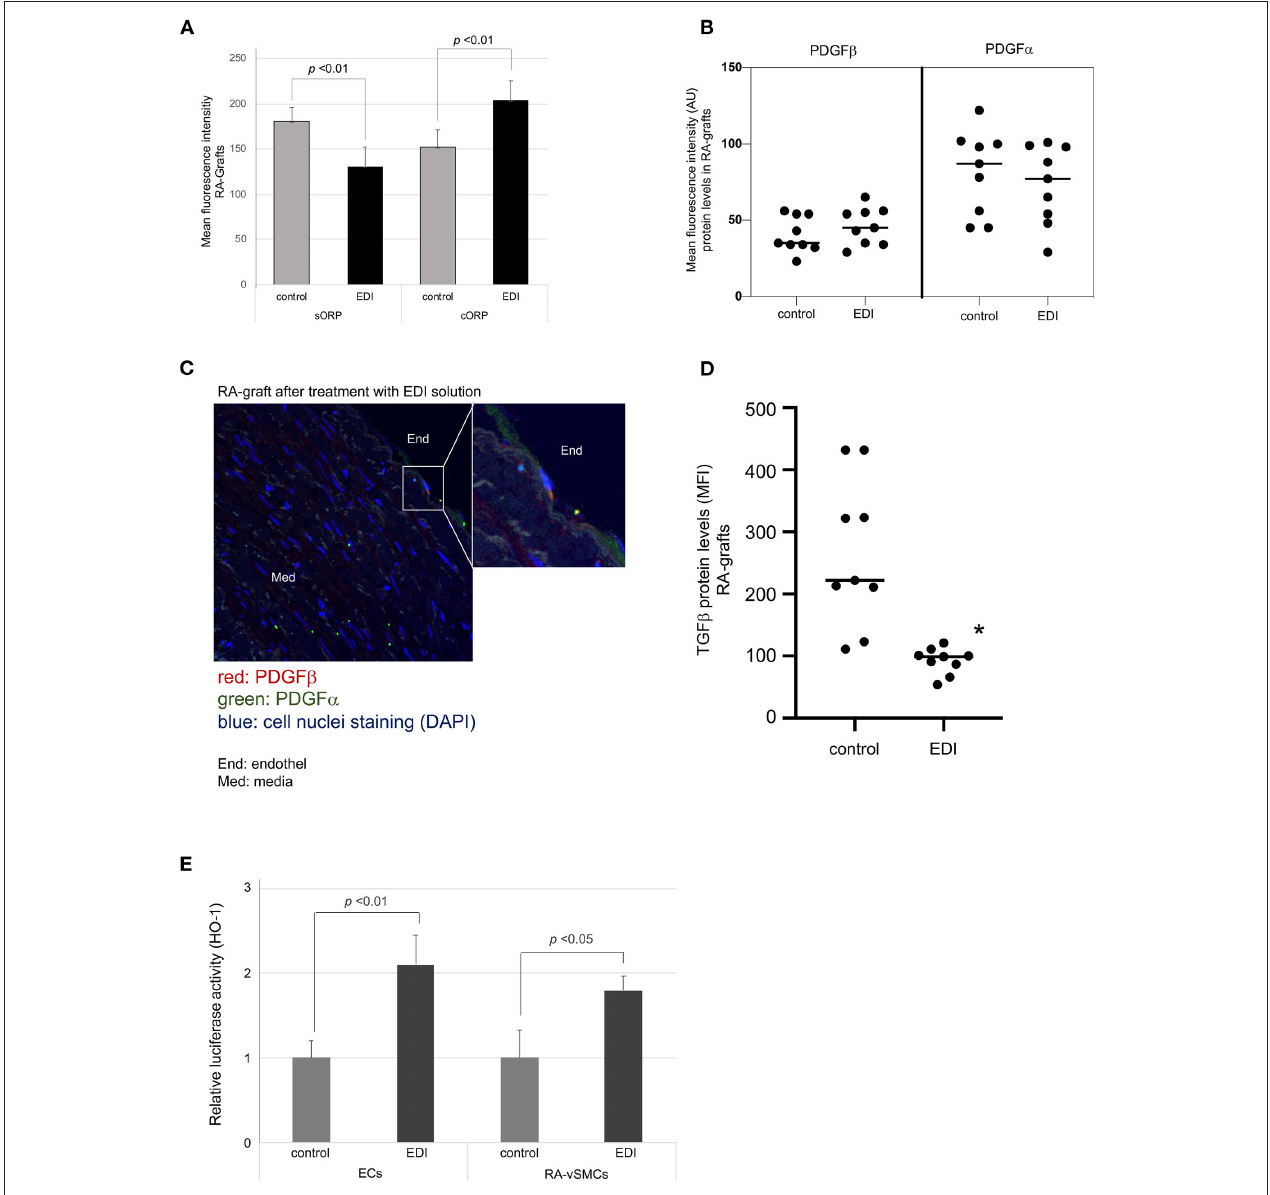
FIGURE 5 | Oxidative damage reduced by EDI treatment. (A) RA specimens of the same patients after different treatments (EDI solution vs. control group) were measured for the static oxidation reduction potential (sORP) as well as the capacity ORP (cORP). Protein expression levels of PDGF α and PDGF β after EDI or RL treatment. (B) Dot blot calculation of mean fluorescence intensity (MFI) of both proteins were presented. (C) PDGF β expression of EDI treated RA samples by IF staining. Magnification of endothelial layer is shown. Red, PDGF α ; green, PDGF β ; blue, cell nuclei staining (DAPI); End, endothel; Med, media. (D) TGF β